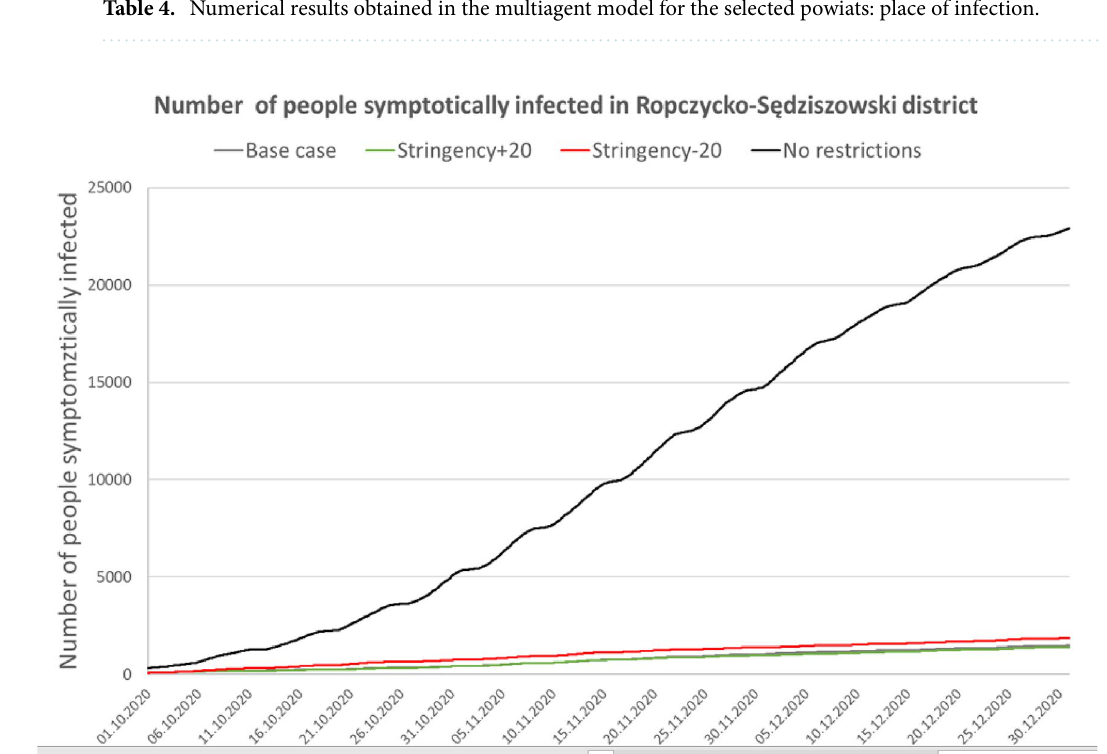
Table 4. Numerical results obtained in the multiagent model for the selected powiats: place of infection.